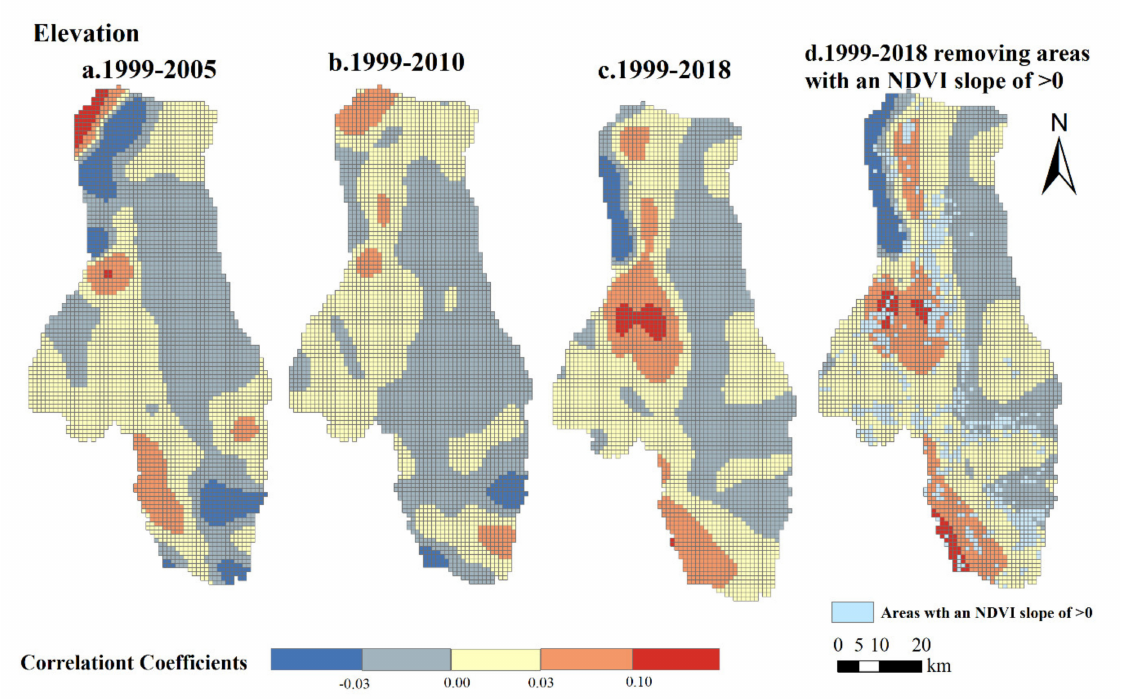
Figure 6. ( a – d ) Spatial patterns of correlation coe ffi cients between elevation and vegetation changes in